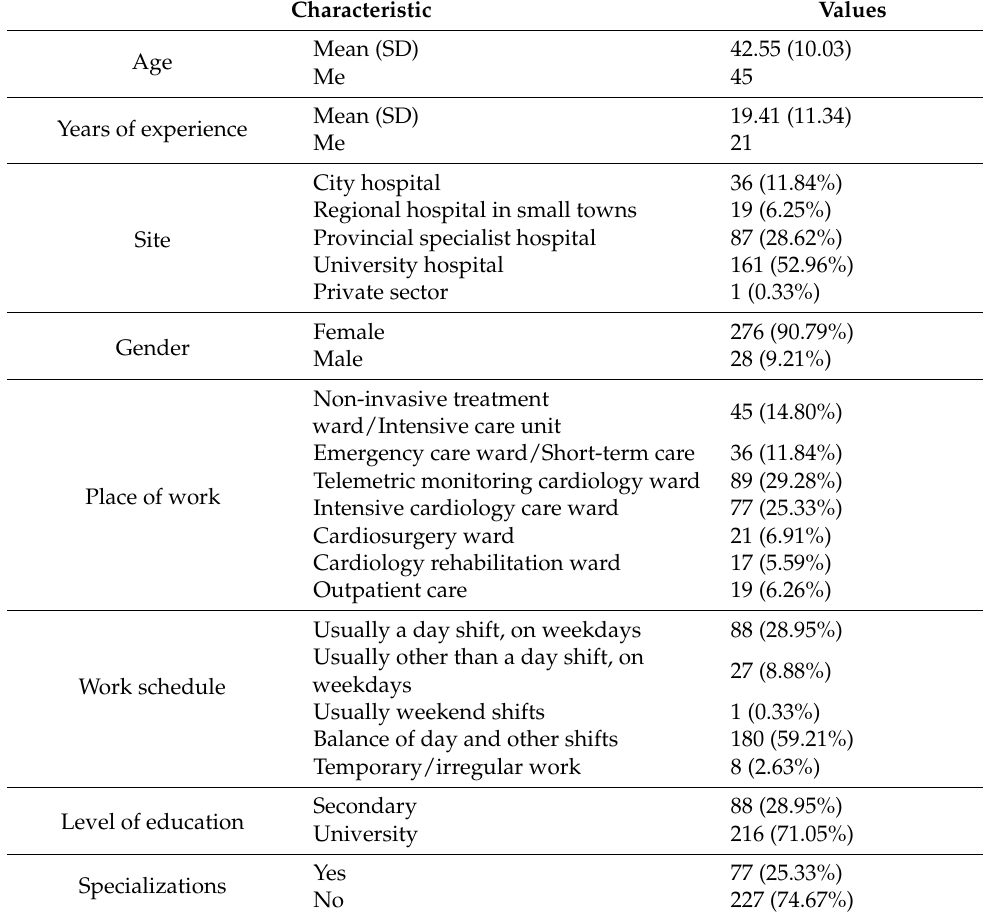
Table 1. Group characteristics of the nurses participating in the study.